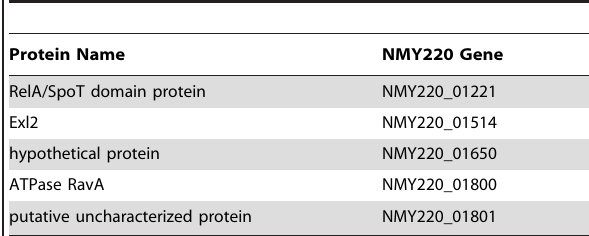
Table 3. Genes found in NM220 and NM233 but not in other sequenced